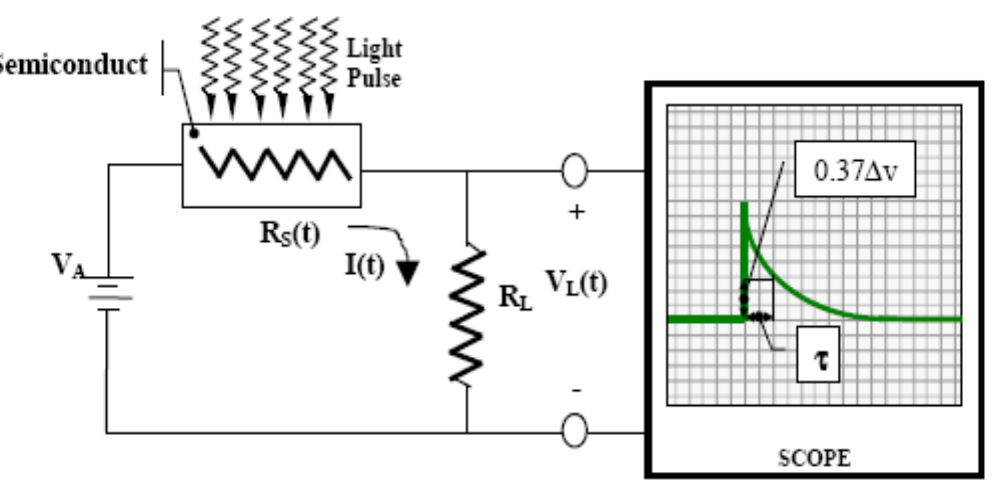
Fig. 1: Experimental setup for carrier life time measurement.